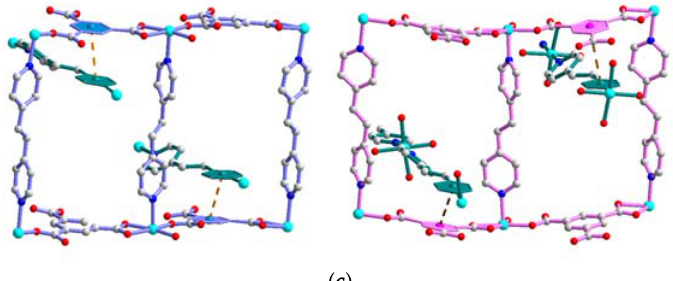
Figure 1. ( a ) Up: 3D supramolecular entangled architecture in 1 showing the interpenetration of two 1D chains ( C and D ) into the rectangular channels formed by 2D double-layered network ( A plus B ) viewing along the a axis. Bottom, middle: 2D double-layers of A plus B viewing along the c axis; right: 2D rectangle-grid layer of A, with grid-dimensions of 10.263 × 13.668 Å; left: 2D rectangle-grid layer of B, with grid-dimensions of 10.184 × 13.668 Å, ( b ) up: 3D supramolecular entangled architecture in 1 viewing along the c axis showing the interpenetration of two 1D chains ( C and D ) in an alternate array. Bottom: two 1D linear chains of C , and D , ( c ) π – π interactions between the pyridine rings of anti -dpe ligands and the benzene rings of the Hbtc 2 − or btc 3 − ligands.